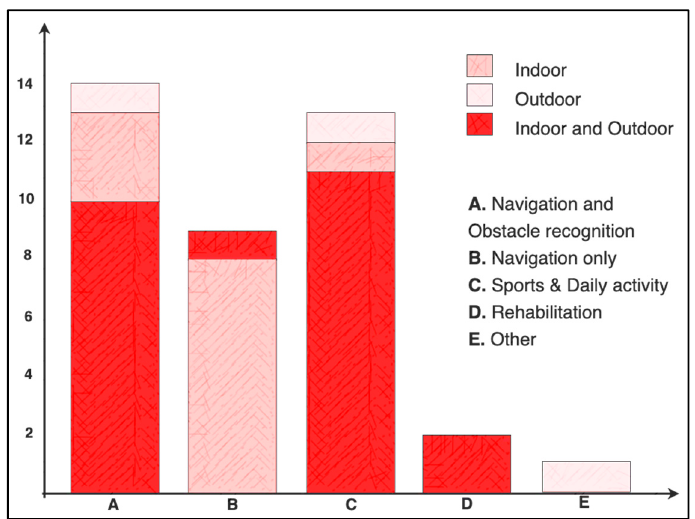
Figure 7. Distribution of the articles selected in the systematic review according to the fields of ap- plication.